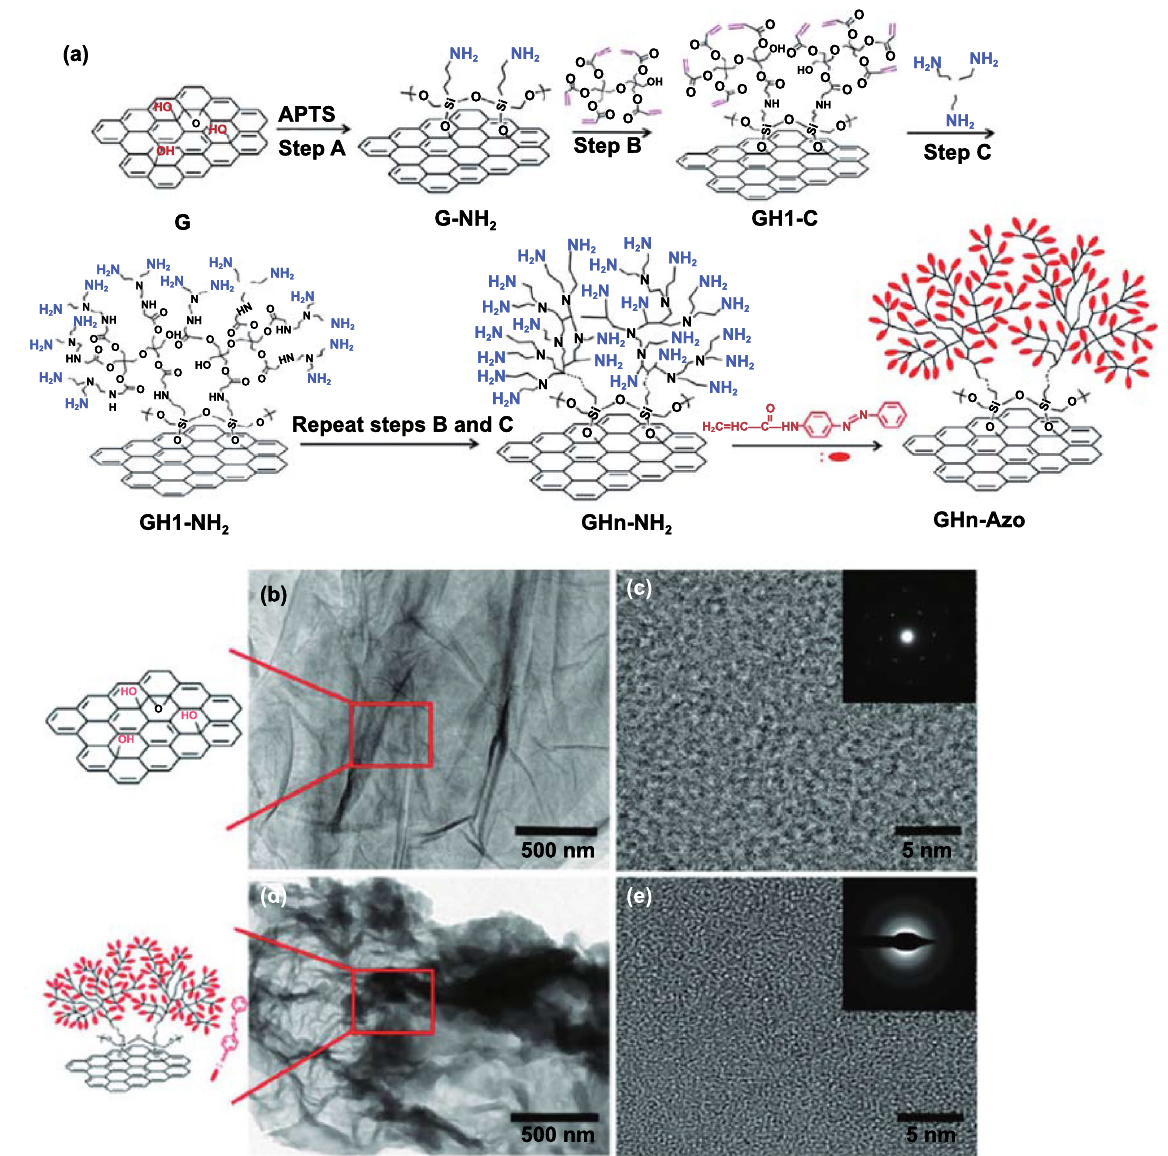
Fig. 10 a Schematic of azobenzene–graphene STFs with hyperbranched structures. G-NH2: graphene hybrids terminated with amine groups via coupling treatment; GH1-C: graphene hybrids terminated with acrylate groups via Michael addition reaction; GHn-NH 2 : graphene hybrids terminated with multitudinous amine groups via layer-by-layer dendritic amplification; n represents the factor of dendritic amplification. GHn- Azo: azobenzene–graphene hybrids with different amplification layers. TEM images and chemical structures of graphene and GH3-Azo hybrids. b Low-resolution and c high-resolution images of graphene. d Low-resolution and e high-resolution images of GH3-Azo hybrids. Inset: FTT patterns